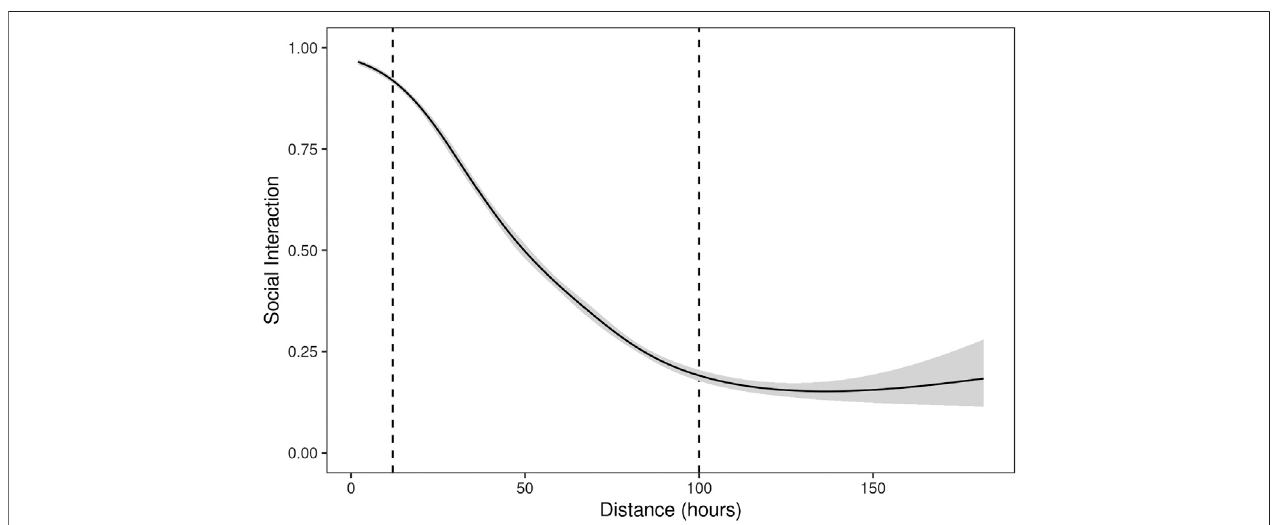
FIGURE 4 | Empirical distance deterrence function estimated with a generalized additive model, describing how the intensity of social interaction, de fi ned as the information fl ow between two settlements and measured by the similarity in their decorated ceramic assemblages, decreases as a function of distance. Shaded area indicates the 95% con fi dence interval for the smooth function. Dashed lines indicate key thresholds in the function at 10 and 100 hours.